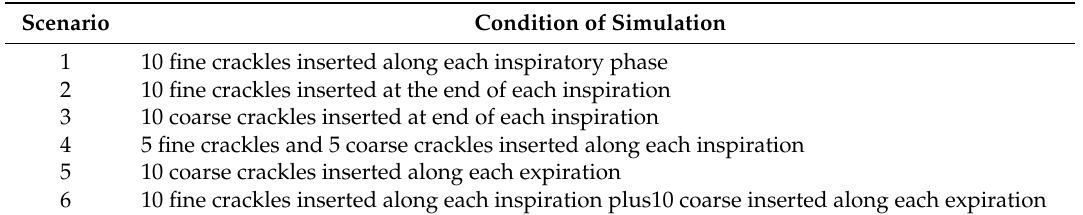
Table 2. Simulated scenarios for performance evaluation of the proposed